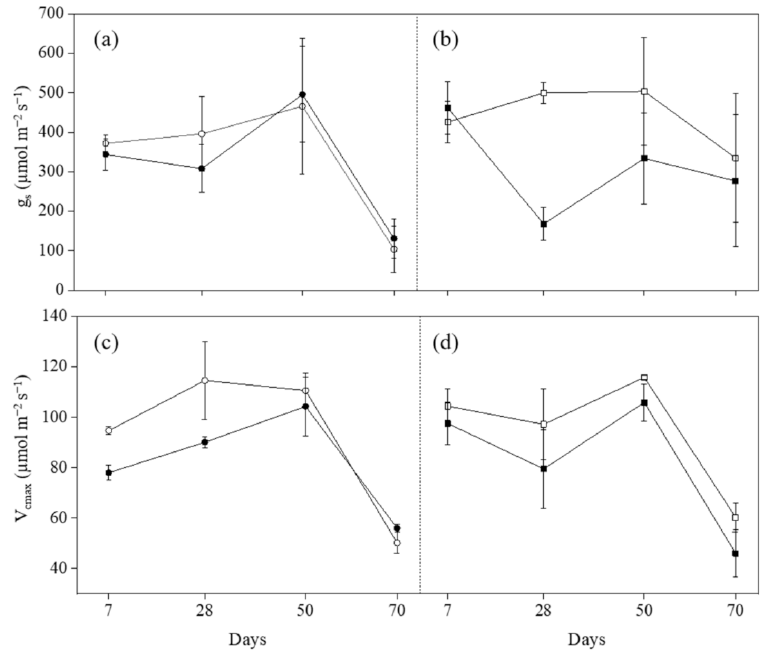
Figure 2. Stomatal conductance (g s ) ( a , b ) and maximum RuBP-saturated rate of carboxylation (V cmax ) ( c , d ) in durum wheat cultivars Claudio (circle, left ) and Mongibello (square, right ) exposed to 0 (open) or 80 (closed) ppb of ozone (5 h day − 1 ) at different growth stages (7, 28, 50, 70 days from the beginning of exposure). Data are shown as mean ± standard deviation (n = 3). A vertical dashed line separates the